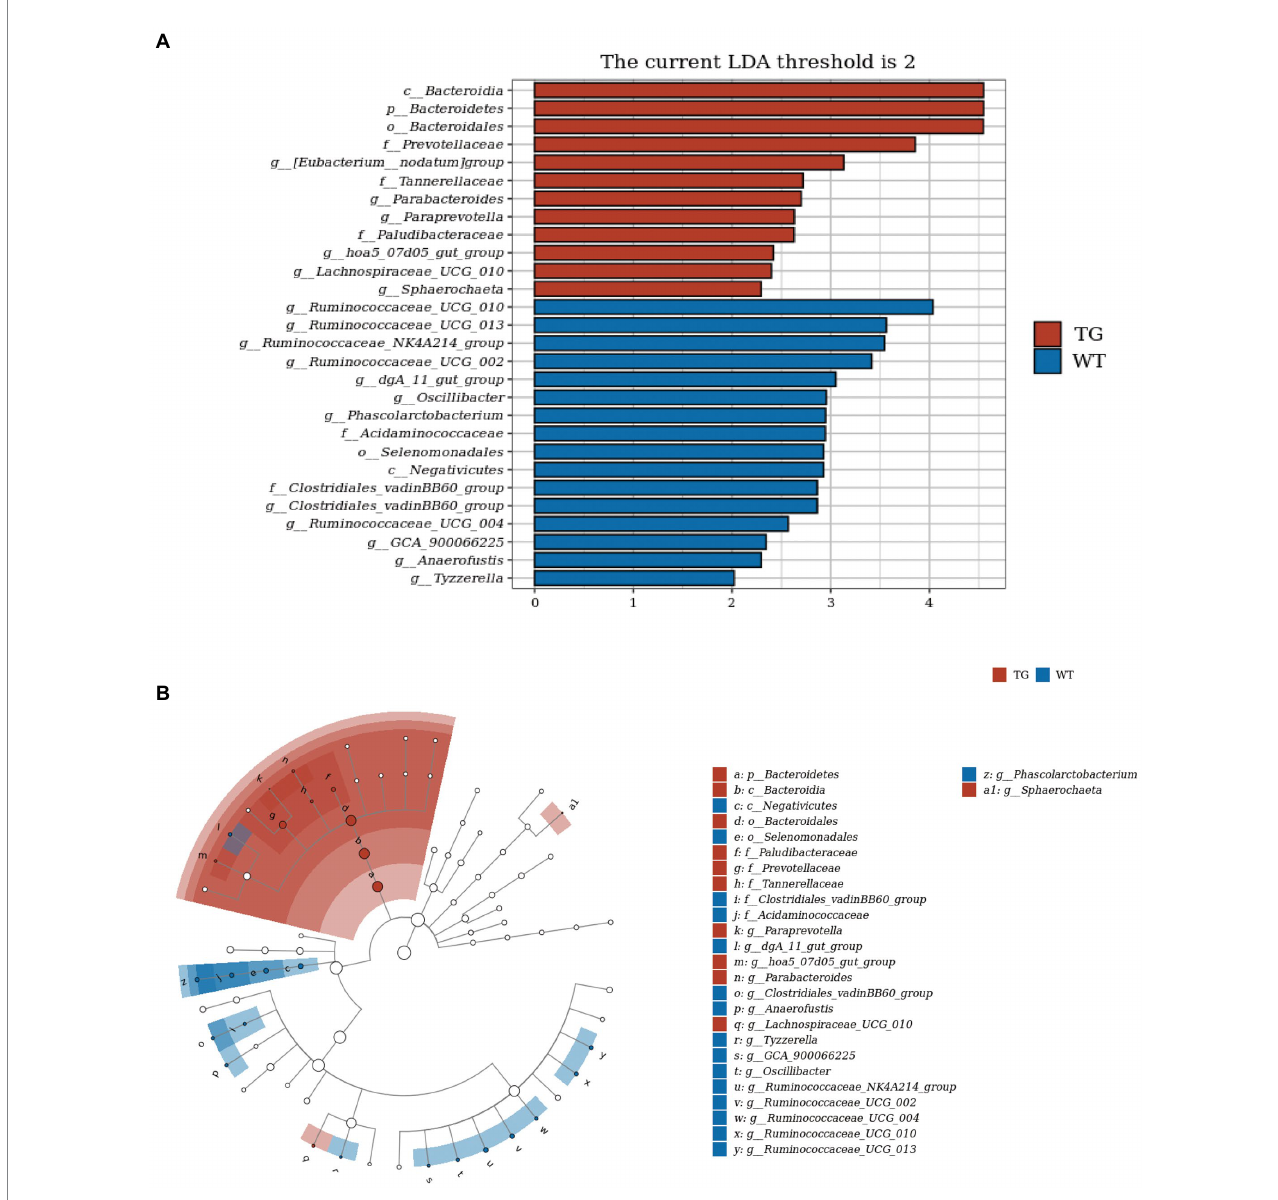
FIGURE 6 TLR4 modulated key phylotypes of gut microbiota in TG and WT. (A) LDA score. The enriched taxa with an LDA score > 2 is displayed in bar chart ( p < 0.05). A larger LDA score indicates a more prominent microbiota composition. (B) LEfSe analysis on microbes in sheep feces on TLR4. The colored nodes from inner circle to outer circle showed the hierarchical relationship of all taxa from the phylum to the genus level. The enriched taxa in TG sheep were reported in red whereas taxa enriched in WT sheep were displayed in blue, then taxa with no significant variation were painted in white. The size of the diameter of each circle represents the taxa abundance. N = 5